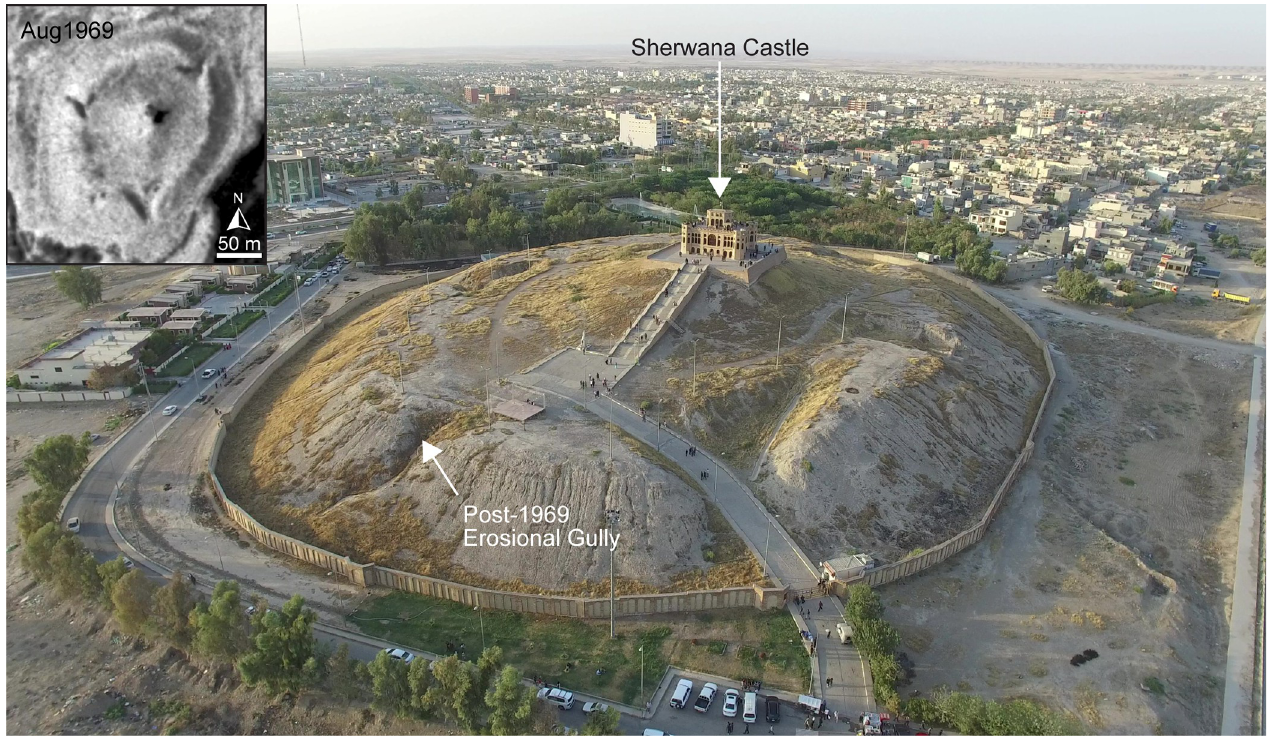
Fig 8. UAV-captured aerial view of Qala Shirwana showing erosional gullies on the sides of the mound (facing northwest). Figure inset shows the site as it appears in 1969 CORONA imagery (courtesy of the USGS and CORONA Atlas; https://corona.cast.uark.edu/atlas#zoom=16&center=5044266,4111020). See Fig 1 and CORONA Atlas URL link for site location. UAV image courtesy of the Sirwan Regional Project.